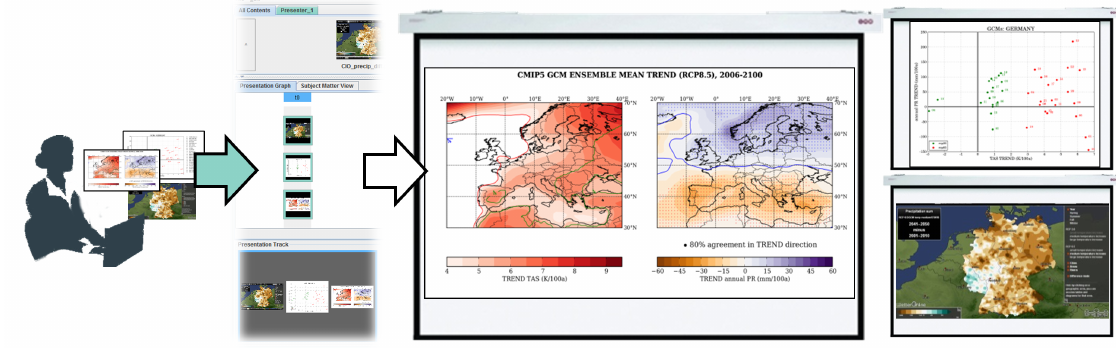
shown on the displays of the room.